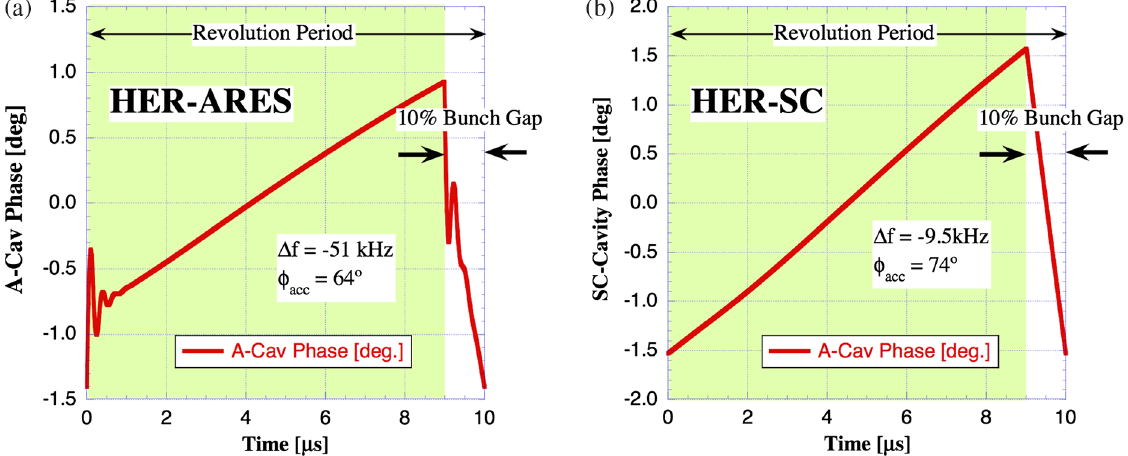
FIG. 5. Simulation results of the phase modulation in the ARES cavities (a) and SCCs (b) for HER to calculate the vector sum shown in Fig. 4(b).